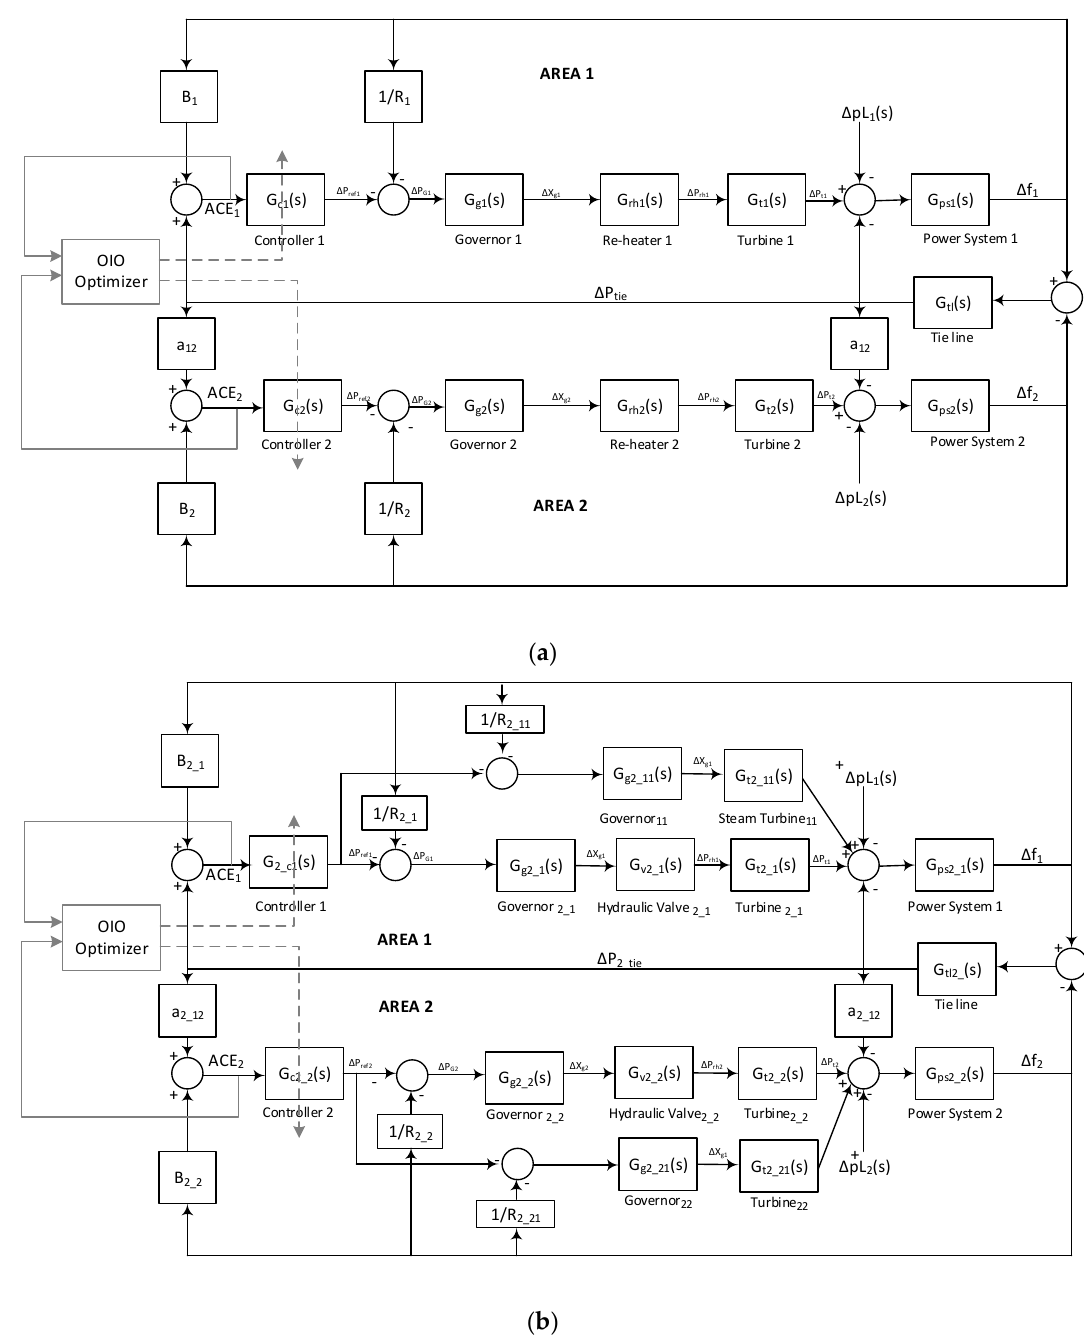
Figure 1. Two ‐ area power system models. ( a ) Test system ‐ 1; ( b ) Test system ‐ 2. Figure 1. Two-area power system models. ( a ) Test system-1; ( b ) Test